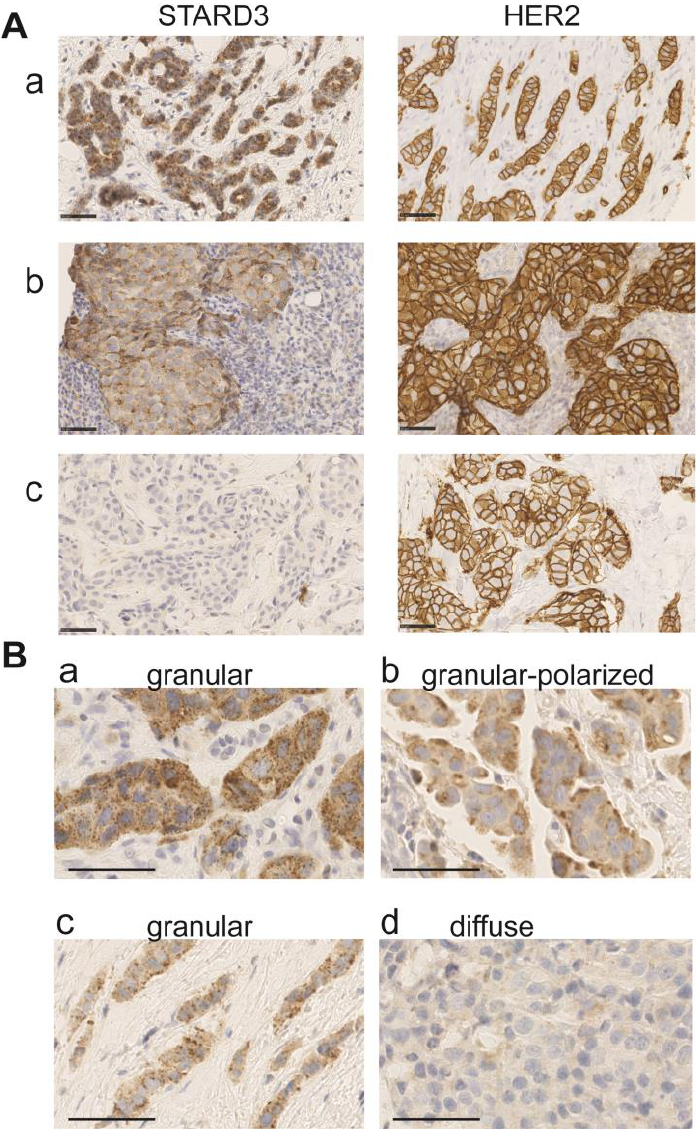
Figure 4. STARD3 staining patterns in breast cancer. ( A ) Representative immunohistochemistry signals for STARD3 and HER2 on three biopsies. STARD3 protein is expressed at high levels in the majority of HER2-positive tumors (a and b). STARD3 expression is absent in some HER2-positive tumors (c). ( B ) Staining patterns for STARD3 in breast tumors. STARD3 is predominantly detected with a granular scattered pattern in the cytoplasm of cancer cells (a and c). In some cases, the granular STARD3 staining is polarized (b). In a few cases, the staining is weak and diffuse in the cytoplasm (d). Bars are 50 μ m, nuclei are counterstained in blue with hematoxylin.